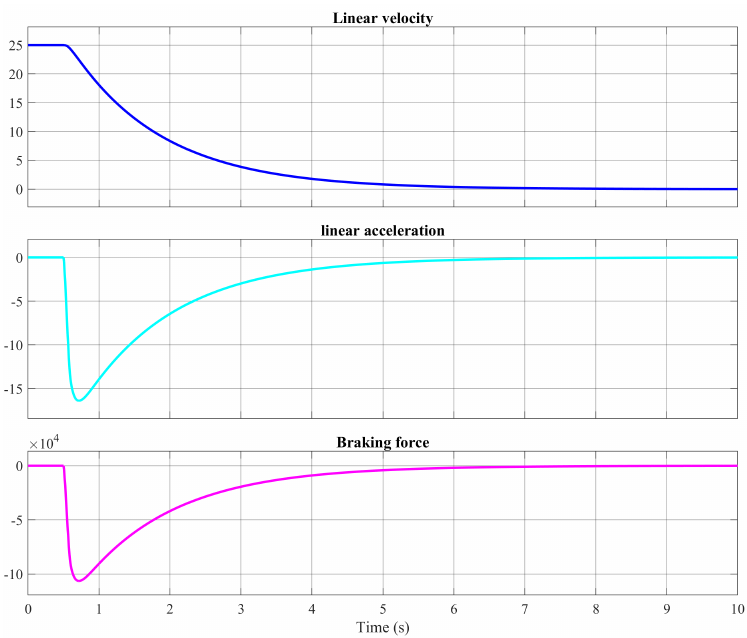
Figure 16. The time domain curve of linear velocity, linear acceleration, and total braking